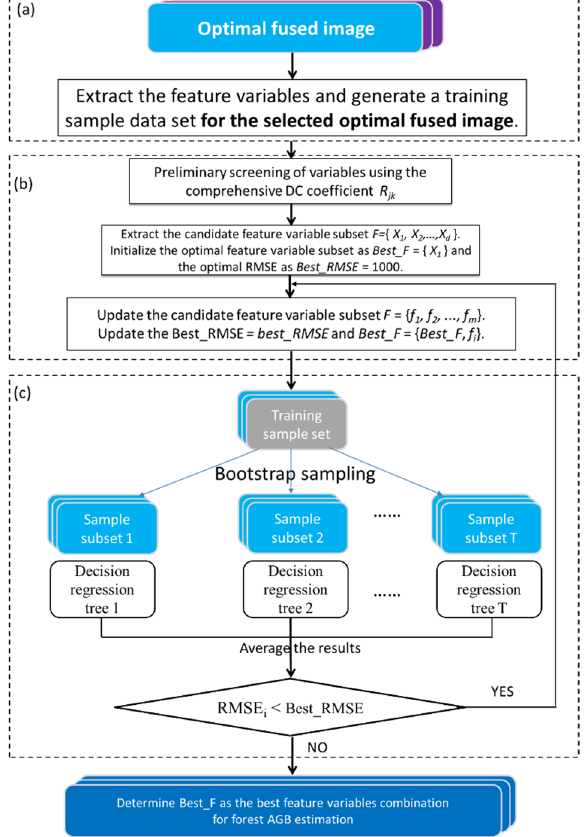
Figure A2. The RFR-based method for optimizing the feature variable combination. ( a ) Selection of the best fused image; ( b ) Feature variable selection based on combinatorial optimization method; ( c ) Basic flow of random forest regression algorithm.